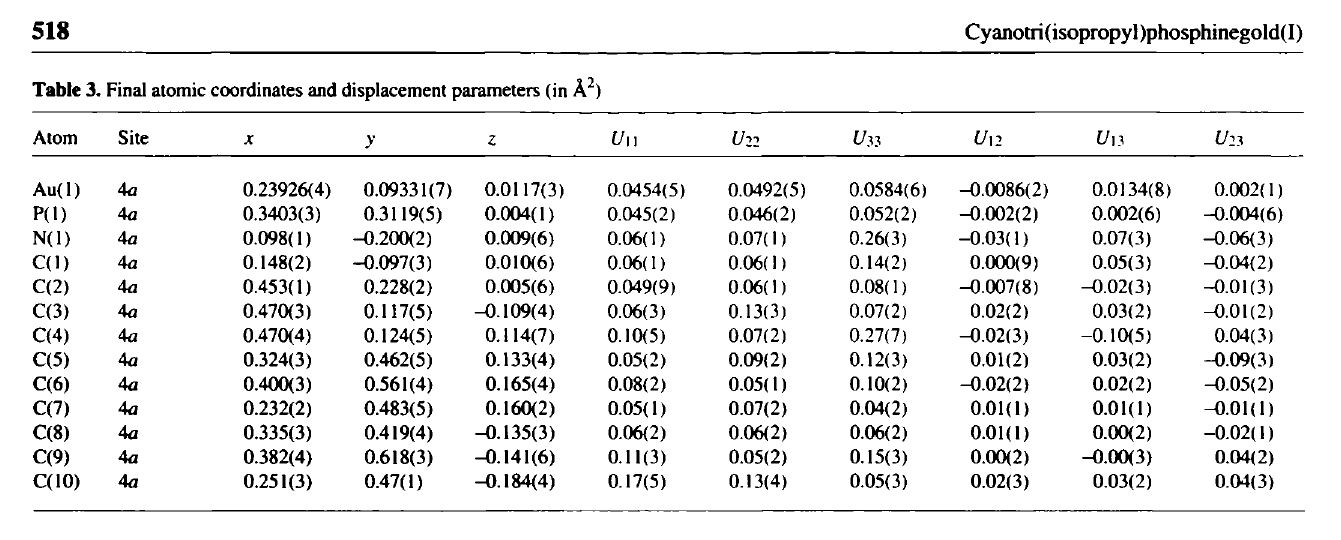
Table 3. Final atomic coordinates and displacement parameters (in Â^) Atom